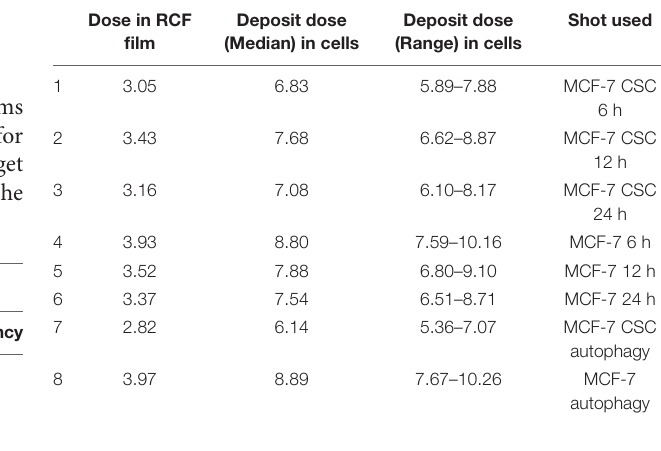
TABLE 2 | Dose summary for each shot of the laser